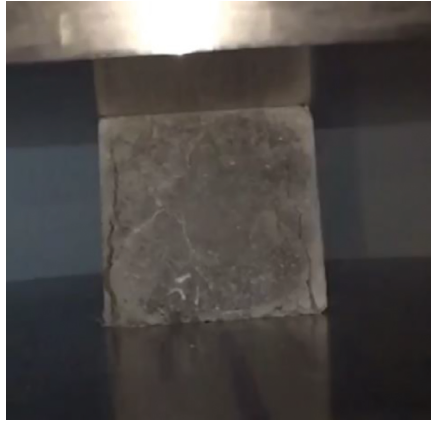
Figure 7: Microcracks on specimen surface after water cooling.